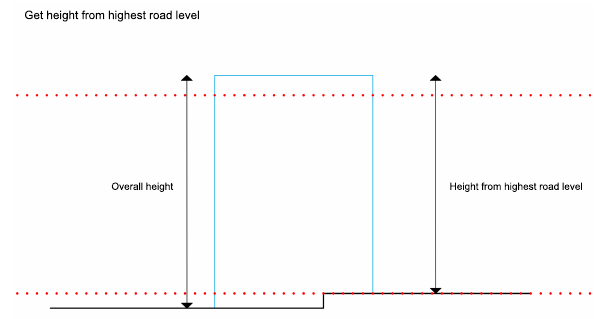
Figure 2. Getting the height of the building from the highest road level